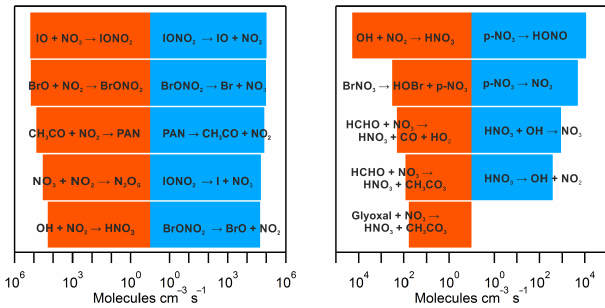
Figure 5. The modelled diurnal profile of NO x at CVO during sum- mer months when photolysis of nitrate (set at 10 × the gas phase HNO 3 photolysis) and a tropospheric PAN source are considered. Shaded areas for NO x are the standard error of the observation. O 3 – green; NO x – black; NO 2 – blue; NO – red; HONO – yellow; PAN – pink.